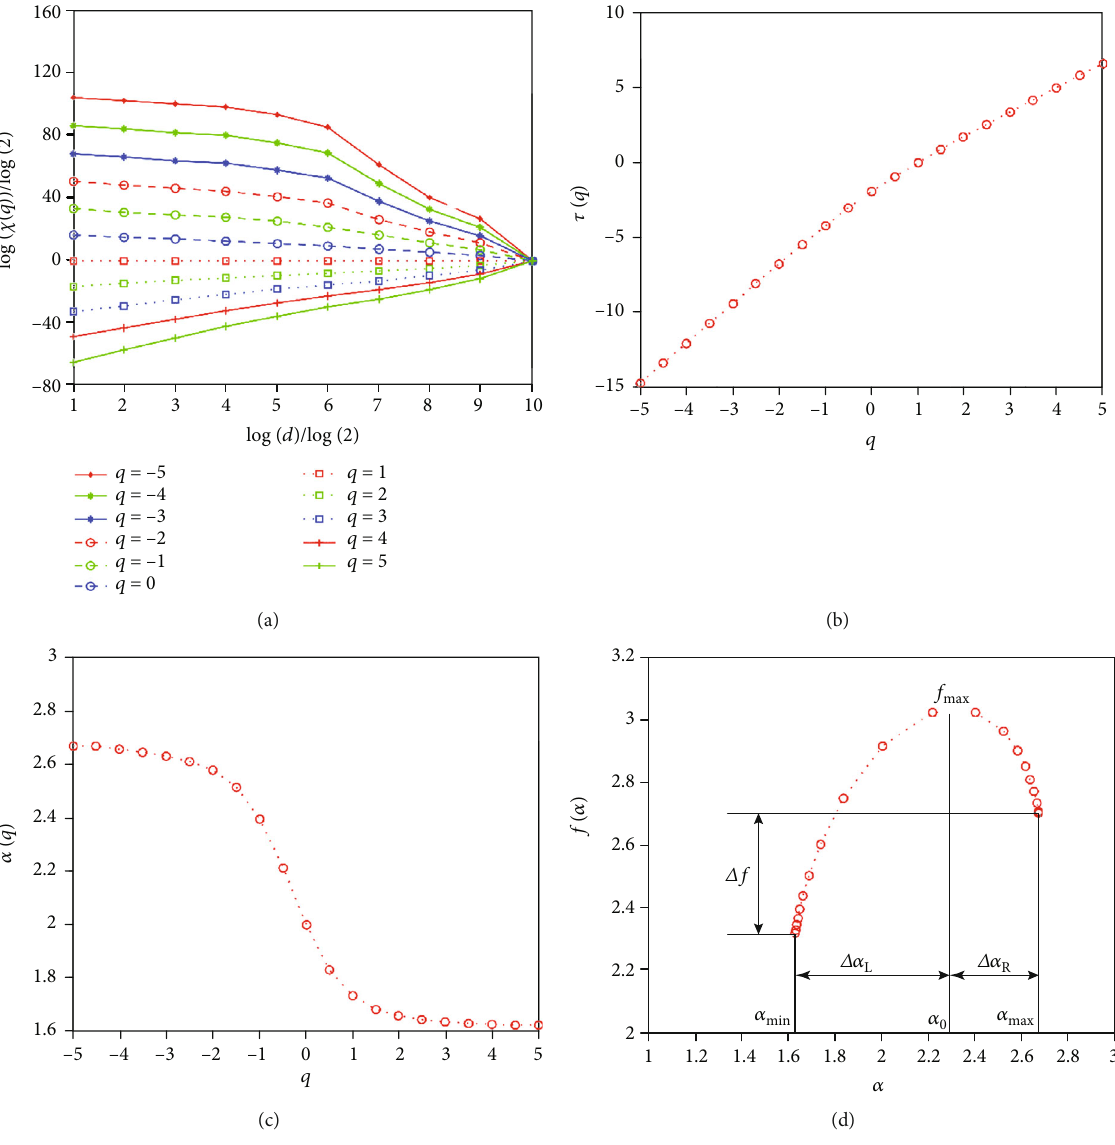
Figure 4: Procedures of multifractal analysis on pore space in dolomites. (a) The partition function of probability to cover the pore space at di ff erent q values. (b) The mass exponent τ varying with the moment q . (c) The singularity exponent α computed from the direct method. (d) The multifractal